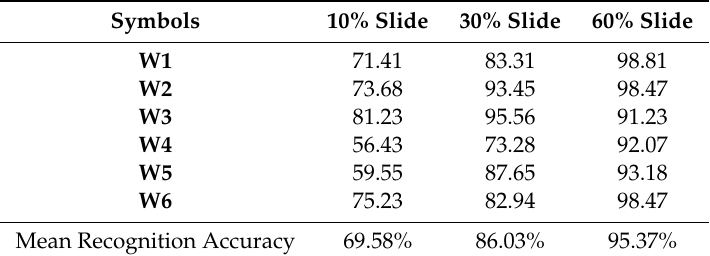
Table 5. WISDM dataset results for di ff erent sliding windows.